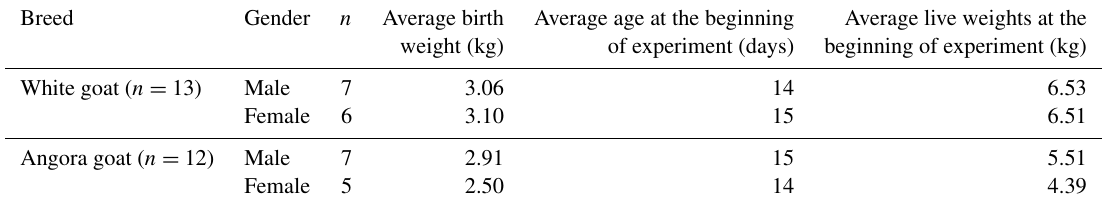
Table 1. Some properties of the experimental goat kids. Breed Gender n Average birth Average age at the beginning Average live weights at the weight (kg) of experiment (days) beginning of experiment (kg) White goat ( n = 13) Male 7 Angora goat ( n = 12)